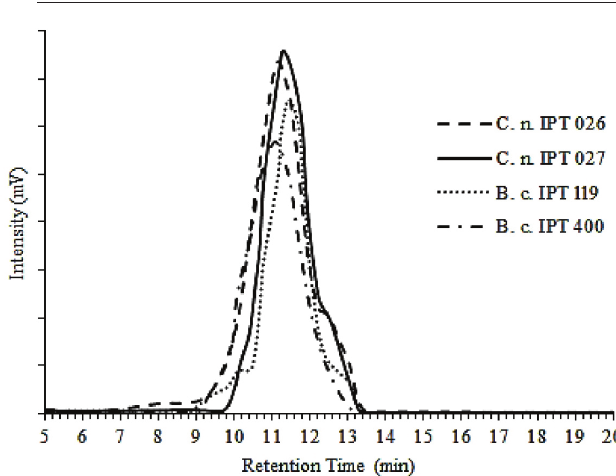
Fig. 5 – HPLC-RI chromatograms of PHAs produced by the C. necator and B. cepacia strains from crude palm oil in sub- merged cultivations